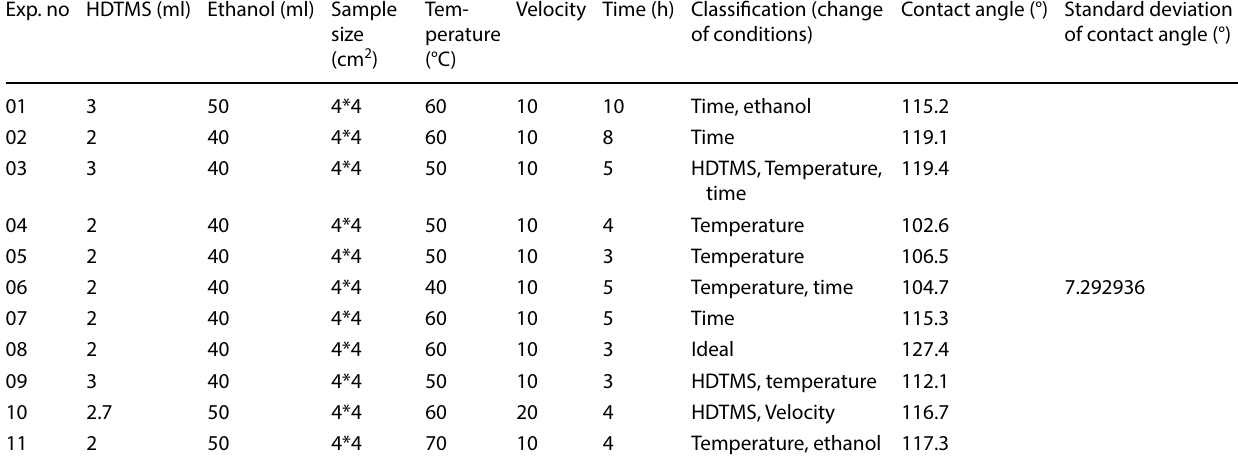
Table 2 Measurement of contact angle for different experiment Exp. no HDTMS (ml) Ethanol (ml) Sample